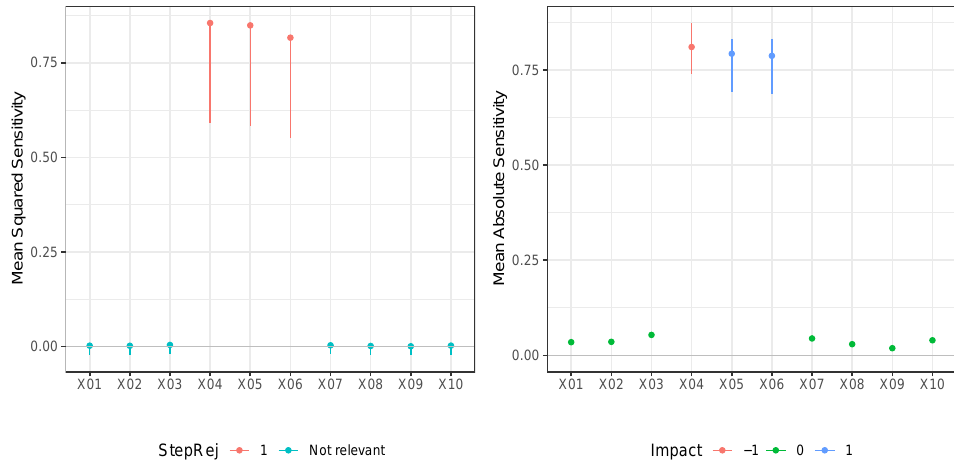
Figure 4. Model M2 (De Vleaux). Case n = 1000. ( left ) Values of test statistic T n and critical values T n − ˆ c ( 1 − α , k ) . ( right ) Values of mean absolute sensitivity along with bootstrap confidence limits with B = 1999 bootstrap replicates and nominal level 1 − α = 0.90 for relevant variables to the model.